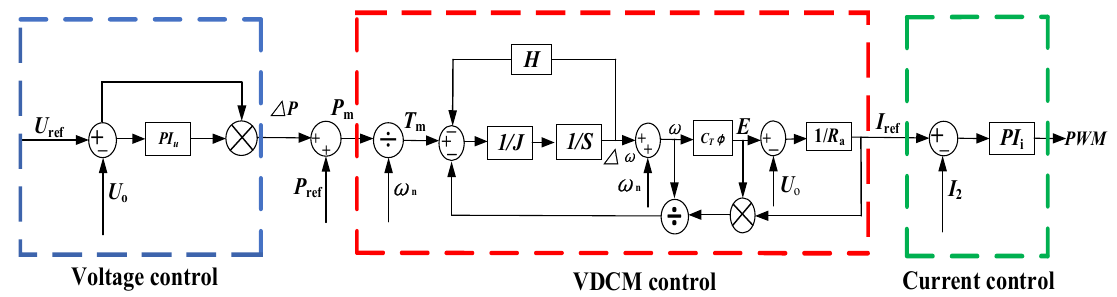
Figure 4. Control block diagram of VDCM.